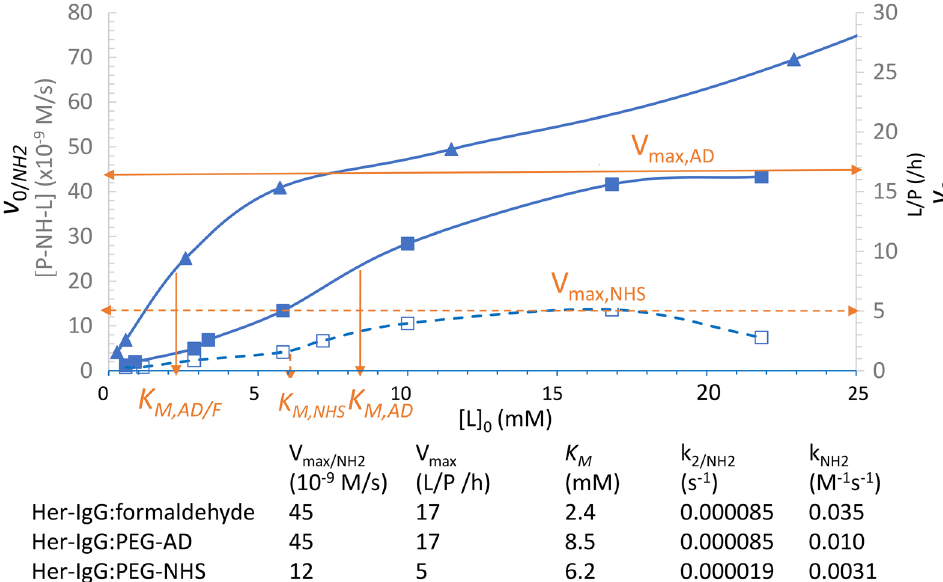
Figure 2. Modified Michaelis–Menten plots for bioconjugation of Her-IgG (5.73 μM) with formaldehyde (triangle) or AD-PEG-N 3 (closed square) by RA versus with NHS-PEG-N 3 (open square). The determined parameters from the plot were indicated in the